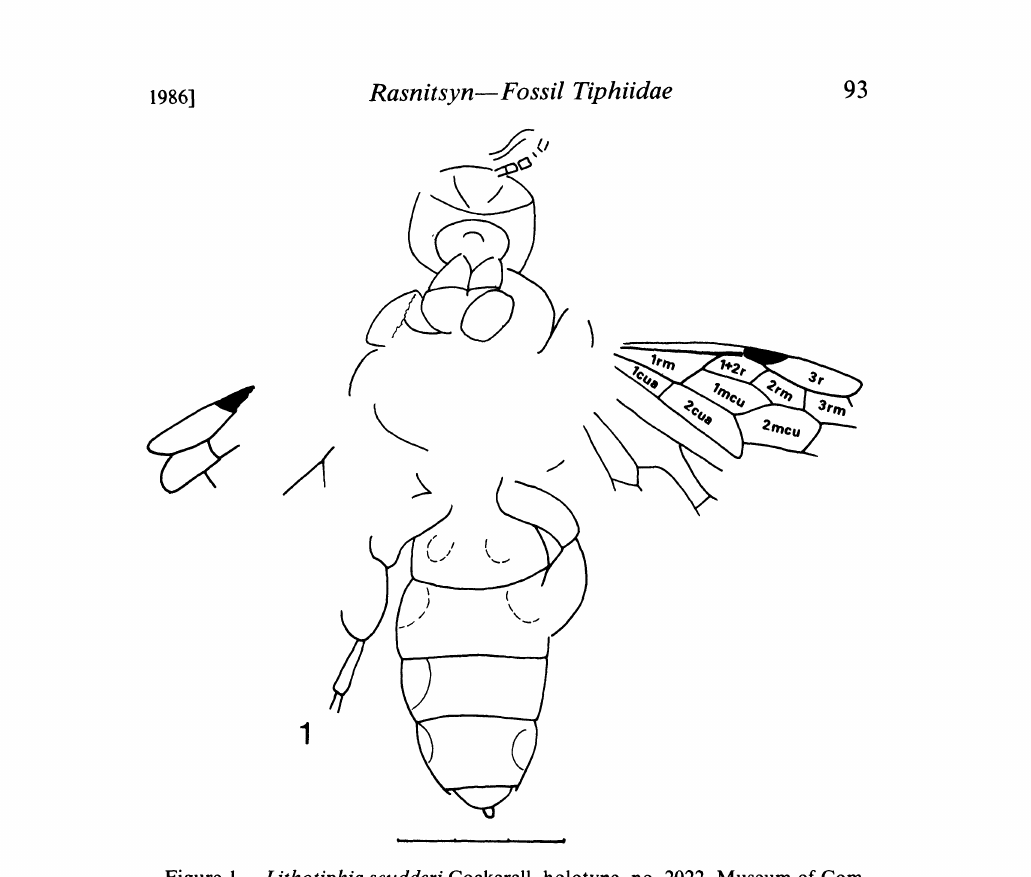
Figure 1. Lithotiphia scudderi Cockerell, holotype, no. 2022, Museum of Com- parative Zoology, Harvard University. Wing cells are lettered. Scale line in all fig- ures, 3